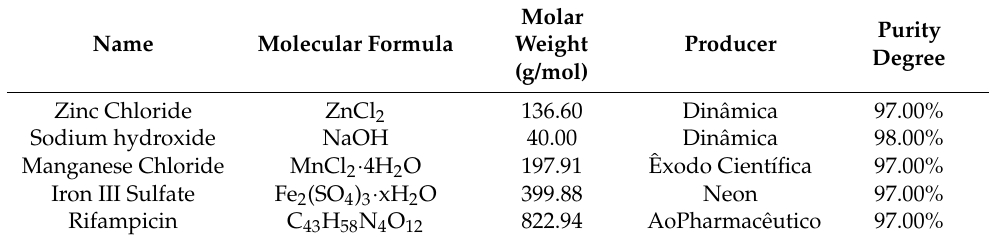
Table 1. Summary of data on reagents